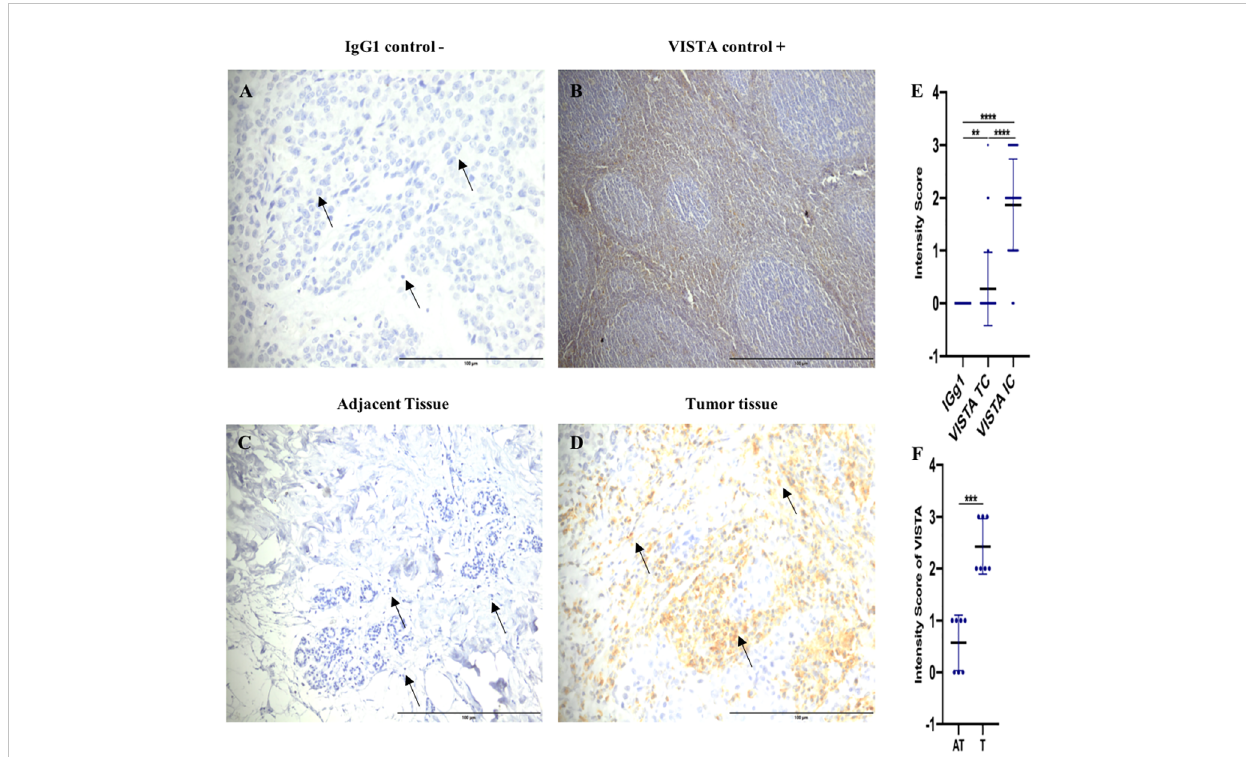
FIGURE 3 Elevated VISTA expression in immune cells of tumor tissues compared to adjacent uninvaded tissue. (A) Negative control staining using Mouse IgG1 Isotype Control (magni fi cation ×40) in breast cancer patient. (B) Tonsil tissue as a positive control (Original magni fi cation, × 10). (C) VISTA negative staining on adjacent tissues (magni fi cation ×20). (D) VISTA-positive staining on tumor tissues (magni fi cation ×40) (E) VISTA expression levels in immune cells, and tumor cells in breast cancer patients. (F) VISTA immunostaining intensity in the tumor microenvironment (Tumor (T) and Adjacent tissue (AT); (n=8)) by IHC. Scale bare 100 µm. **Indicates p-value < 0.01, ***Indicates p-value < 0.001, ****Indicates p-value < 0.0001.